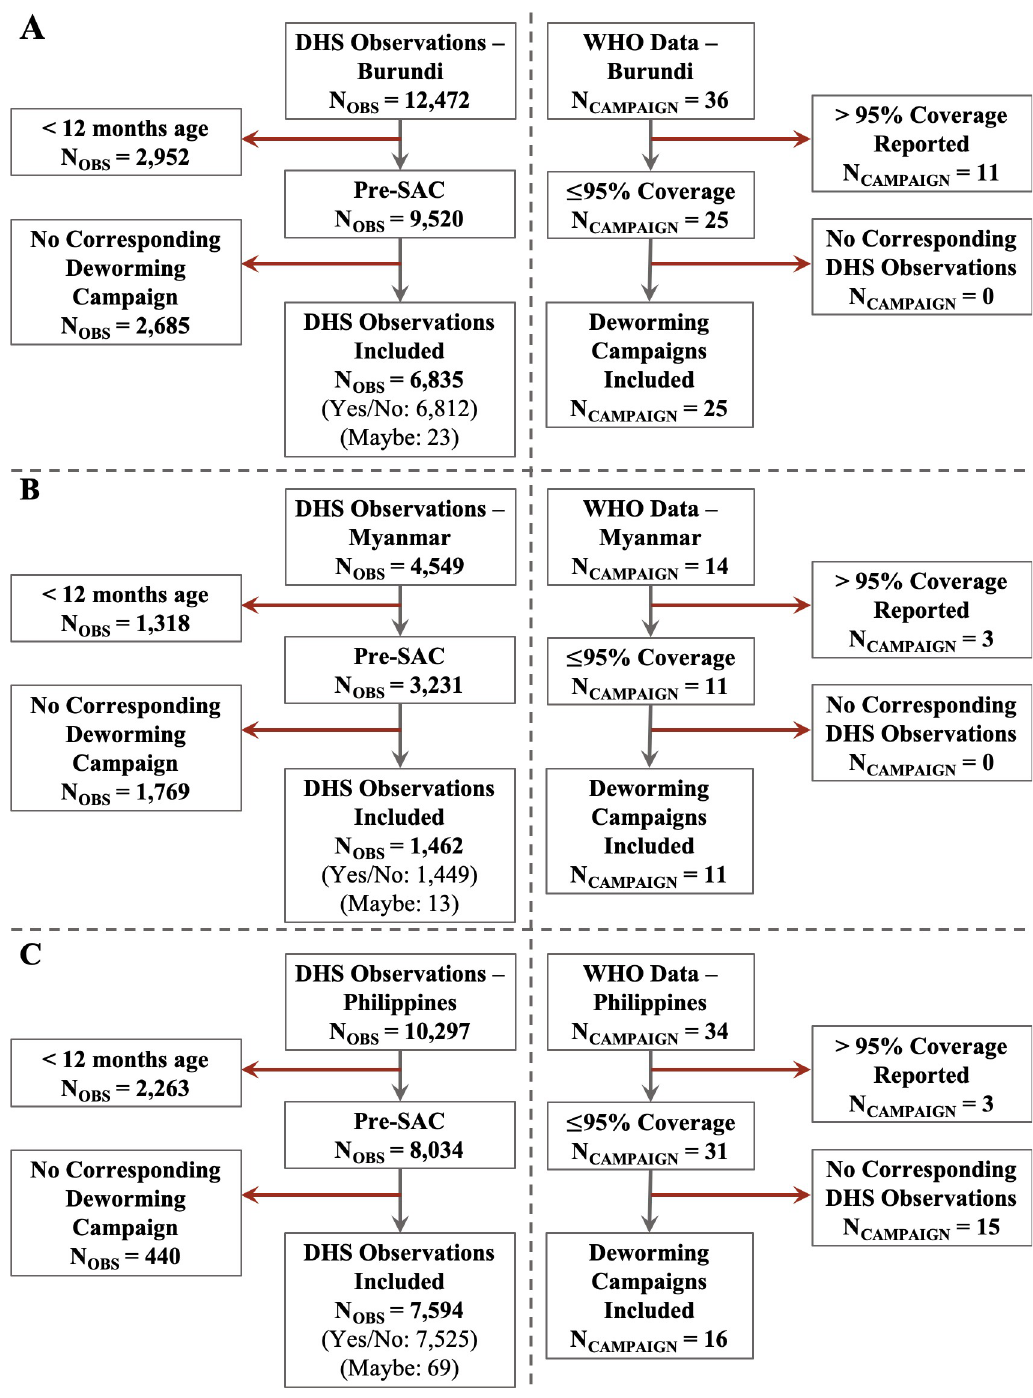
Fig 2. Inclusion and exclusion criteria for DHS and WHO deworming data of pre-school aged children for study countries. The data inclusions and exclusion are provided for the three study countries: (A)Burundi; (B) Myanmar; and (C) Philippines. Key definitions: N OBS : Number of pre-school aged children sampled in DHS; N CAMPAIGN : Number of deworming campaigns reported to WHO; Pre-SAC: Pre-school aged children (12–59 months). In DHS observations, the response of “yes/no” refers to children who were or were not dewormed, while “maybe” refers to mothers who were unable to